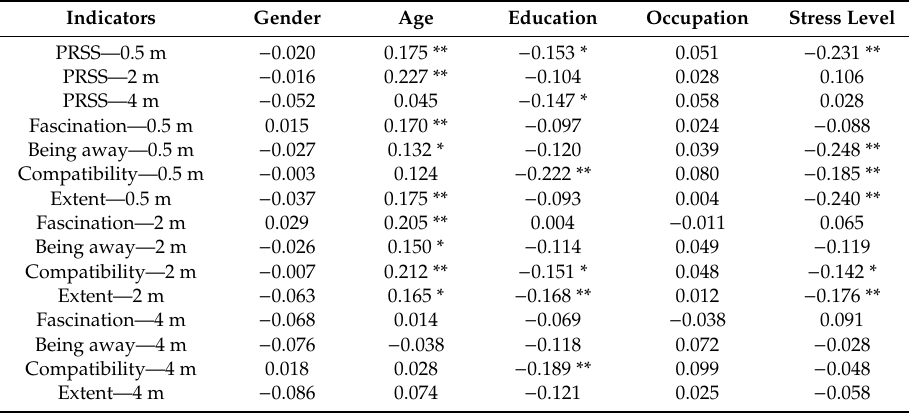
Table 9. Non-parametric tests and Spearman’s Rho correlations between PRSS and demographic / social factors at di ff erent